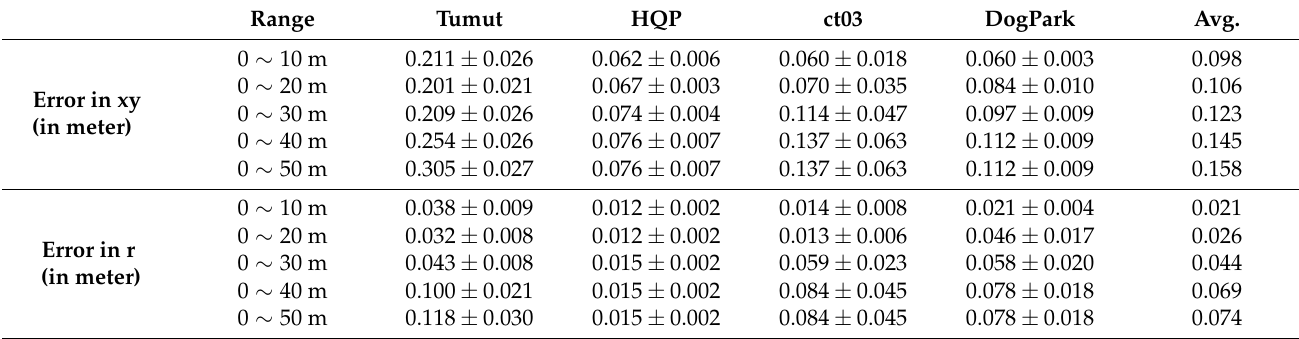
Table 6. The average (cid:96) 2 error (in meter) in cylinder centre coordinates and the average (cid:96) 1 error (in meter) in cylinder radii of our DNN-based tree parameter estimation method. We report multiple results for each dataset by varying the height